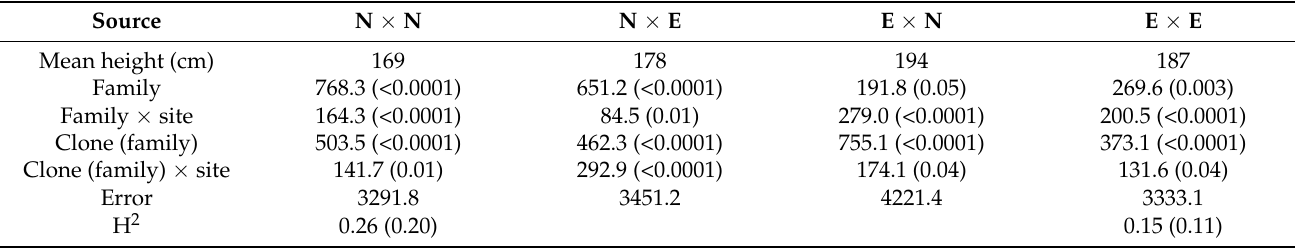
Table 4. Means and estimates of variance components and the broad sense heritabilities (H 2 ) for height of clones within families after ten growing seasons at eight sites (sites 11–18). In parentheses, p -values of variance components and standard error of the